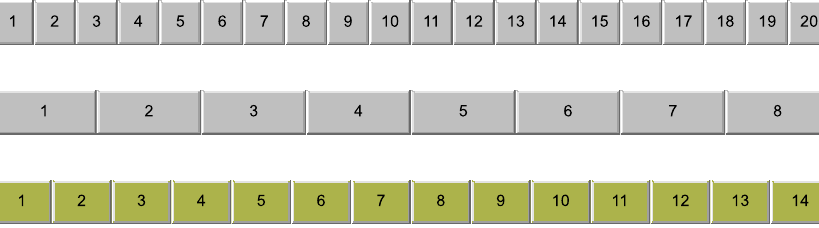
Figure 11. Simulation of the state-updating algorithm using Matlab (MathWorks ® ).